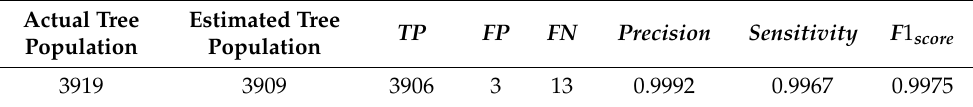
Table 2. Performance assessment of the automated trees detection and counting methodology, expressed in terms of the metrics defined to that purpose.